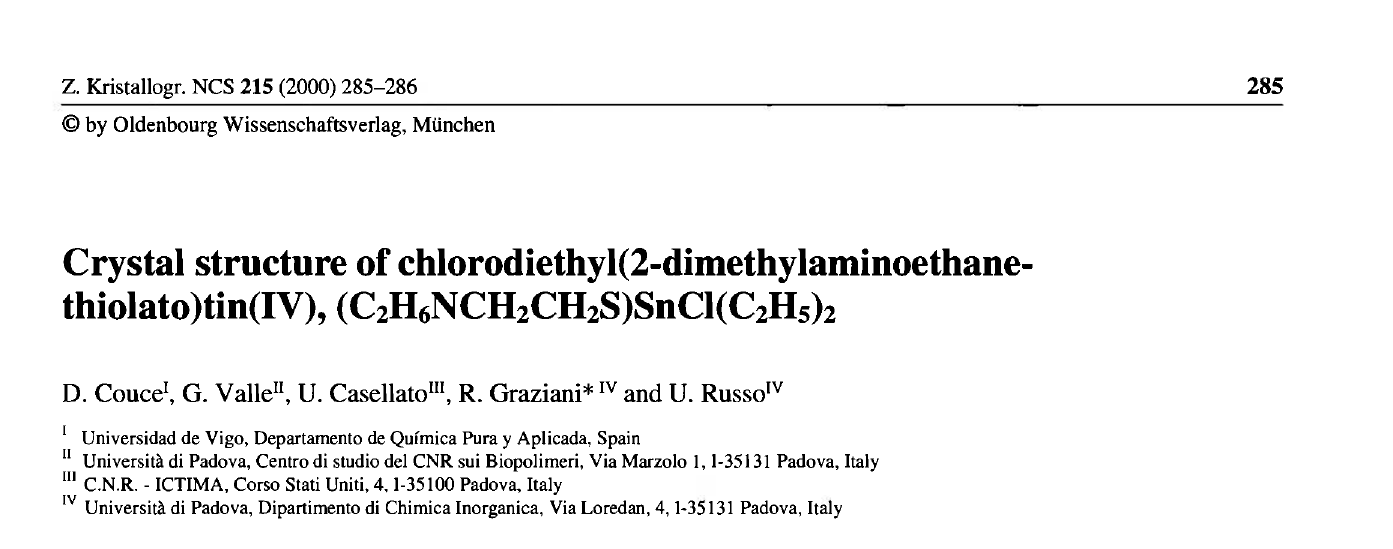
Table 1. Data collection and handling.